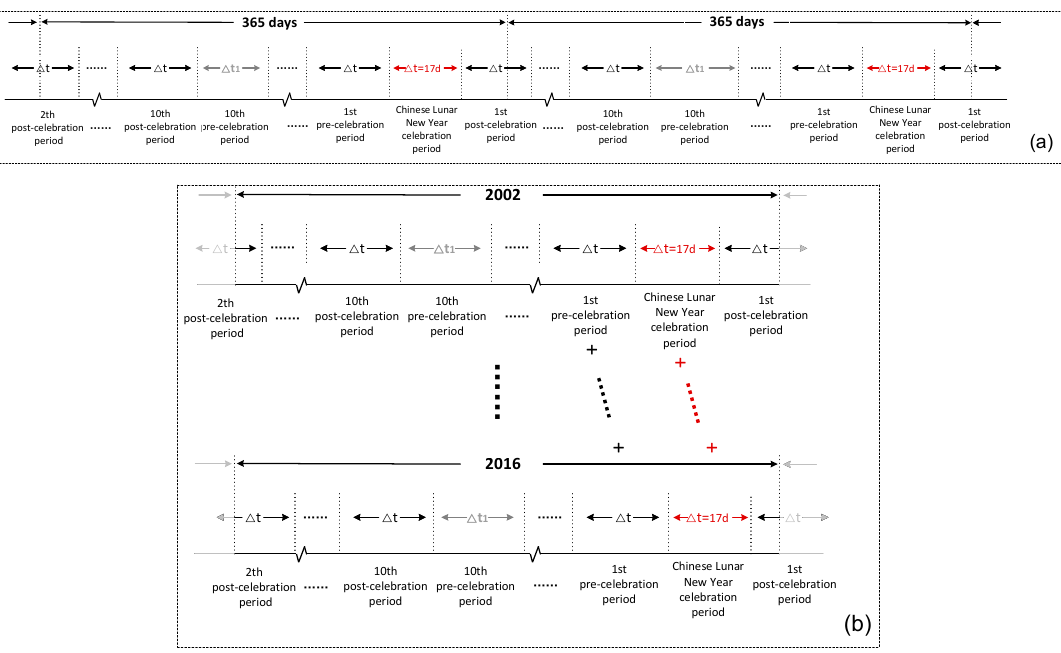
Figure 3. ( a ) The 17-day time division schema and ( b ) the historical PM 2.5 data fusion schema.